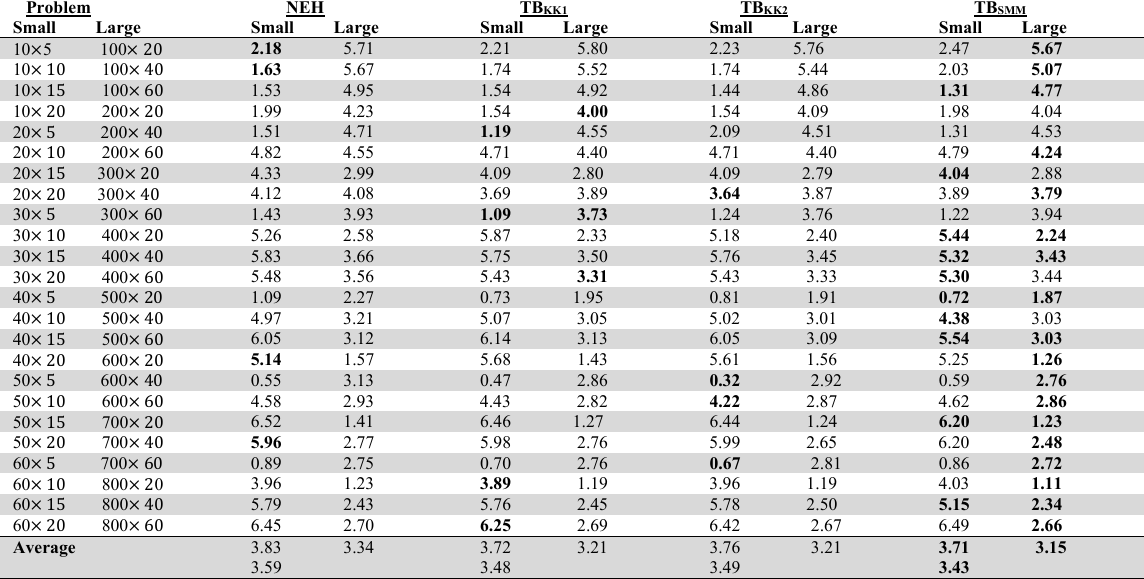
ARPD values for different tie breaking rules on VRF benchmarks NEH Problem Small Large Small 100 ×